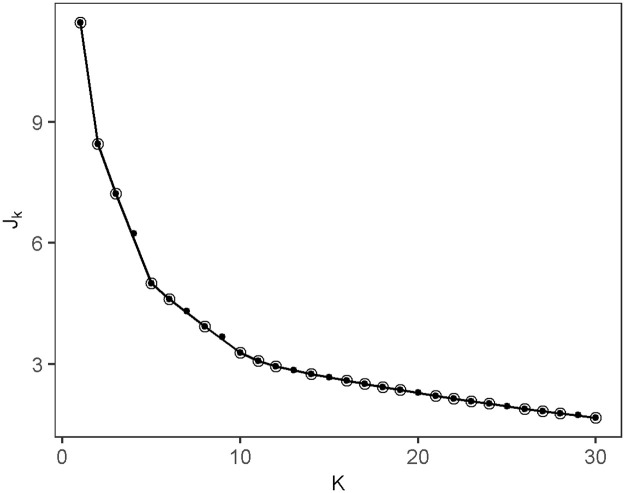
The value of the contrast function JK for 1 ≤ K ≤ Kmax = 30 for House 55.Circles indicate the convex hull points of (K, JK).